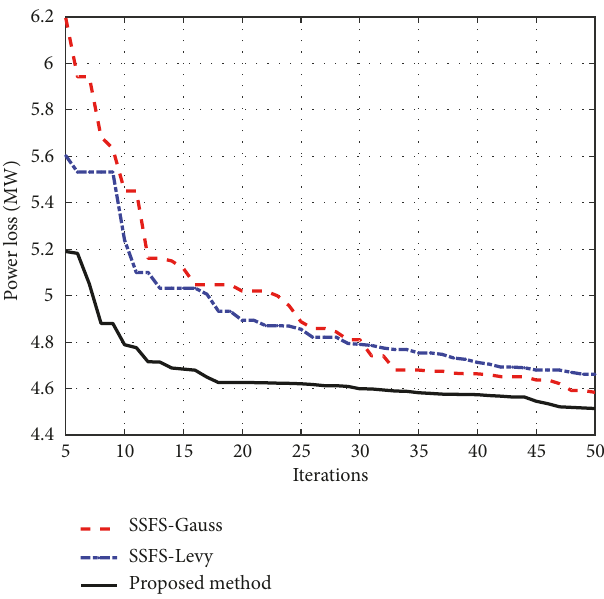
Figure 7: The best run obtained by three methods for power loss optimization of IEEE 30-bus